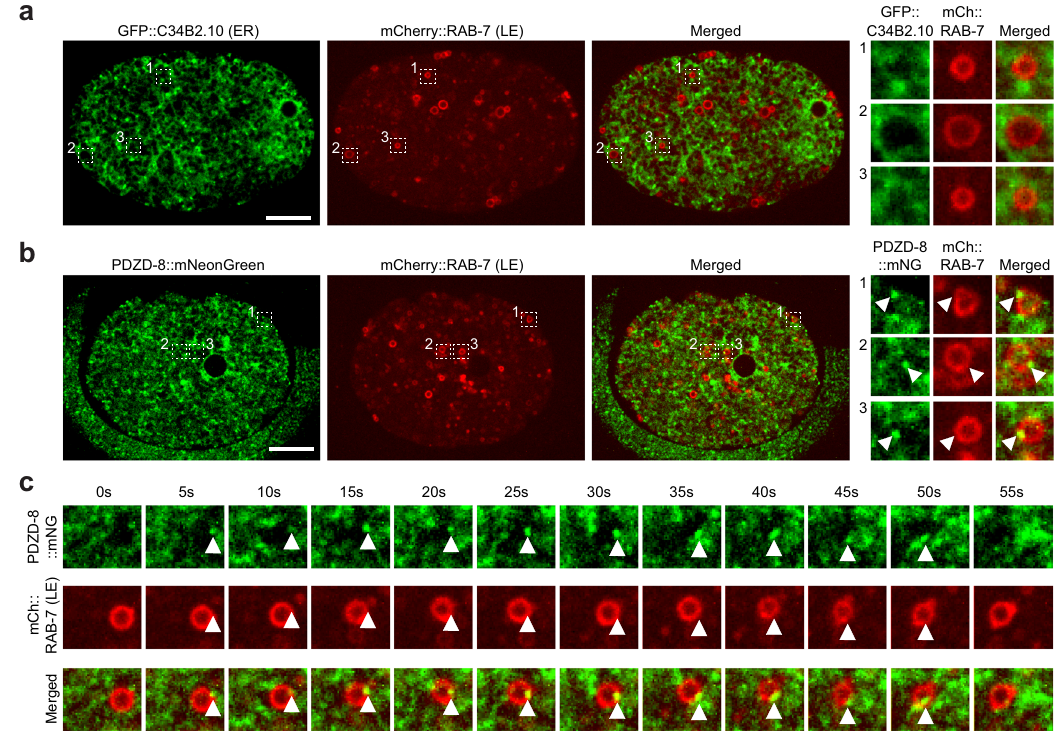
Fig. 6 PDZD-8 localizes to ER-late endosome contacts. a Left: A representative live spinning disc confocal (SDC) image of an equatorial plane of an early embryo from wild-type animals, co-expressing endoplasmic reticulum (ER) marker (GFP::C34B2.10) and late endosome (LE) marker, endogenous RAB-7- tagged with mCherry (mCherry::RAB-7). The image is from the polarity establishment phase. Right: Magni fi ed insets, showing Rab-7 positive LEs wrapped around by the ER, that are outlined by indicated white dotted boxes. Scale bar, 10 μ m. b Left: A representative live SDC image of an equatorial plane of an early embryo from wild-type animals, co-expressing endogenous PDZD-8-tagged with mNeonGreen (PDZD-8::mNeonGreen) and LE marker (mCherry::RAB-7). The image is from the polarity establishment phase. Right: Magni fi ed insets, showing distinct PDZD-8::mNeonGreen puncta present on Rab-7 positive LEs, that are outlined by indicated white dotted boxes. White arrowheads indicate PDZD-8::mNeonGreen puncta that are present on LEs. Scale bar, 10 μ m. c Time-lapse SDC images of a representative Rab-7 positive LE from an early embryo, co-expressing PDZD-8::mNeonGreen and mCherry::RAB-7 (both at endogenous expression levels), over the period of 55 s. White arrowheads indicate PDZD-8::mNeonGreen puncta that is transiently associated with a LE. Scale bar, 10 μ